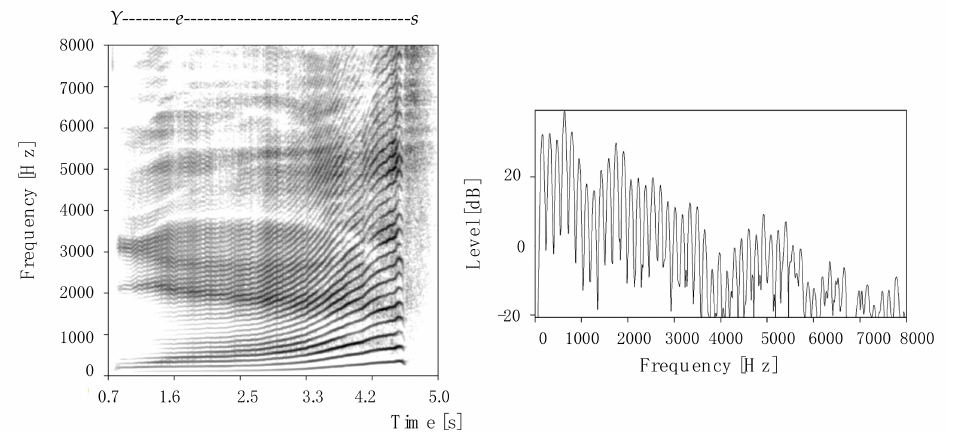
Figure 15. Spectrographic display of the word “yes”, pronounced in an ascending pitch, displayed by the software Praat (by P. Boersma and D. Weenink) as a narrow-band spectrogram ( left ) and a narrow-band spectrum ( right